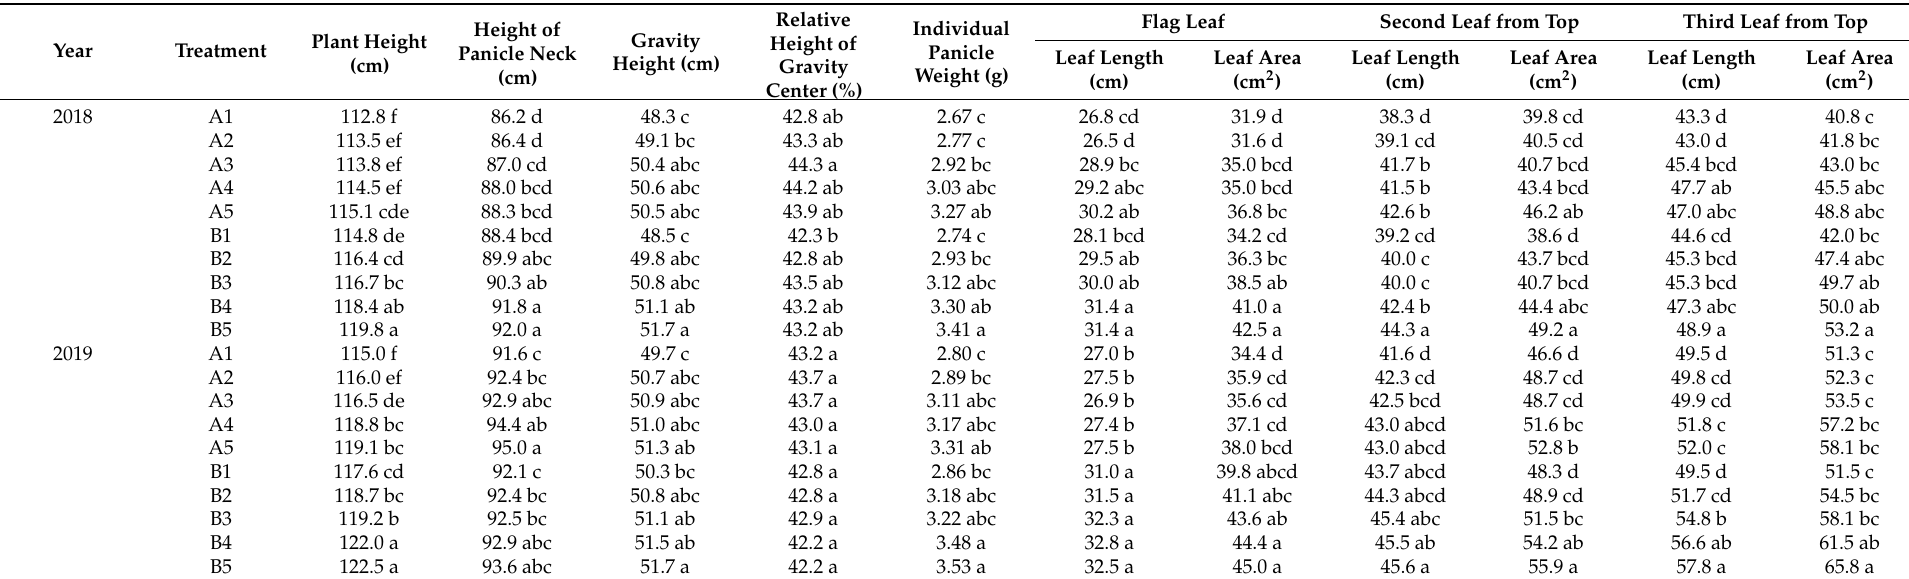
Table 4. Rice plant type characteristics as affected by mechanical transplanting method and planting